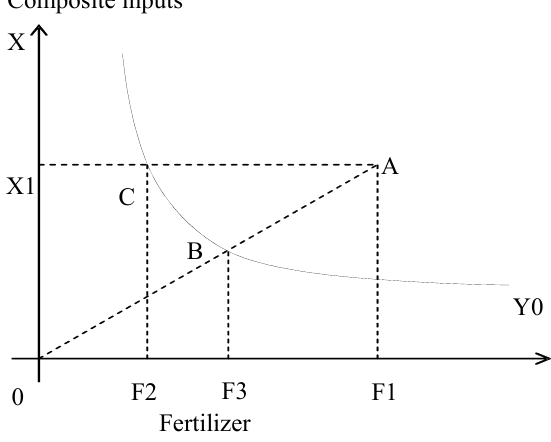
Figure A1. Explaining the concept of fertilizer technical efficiency (FTE).